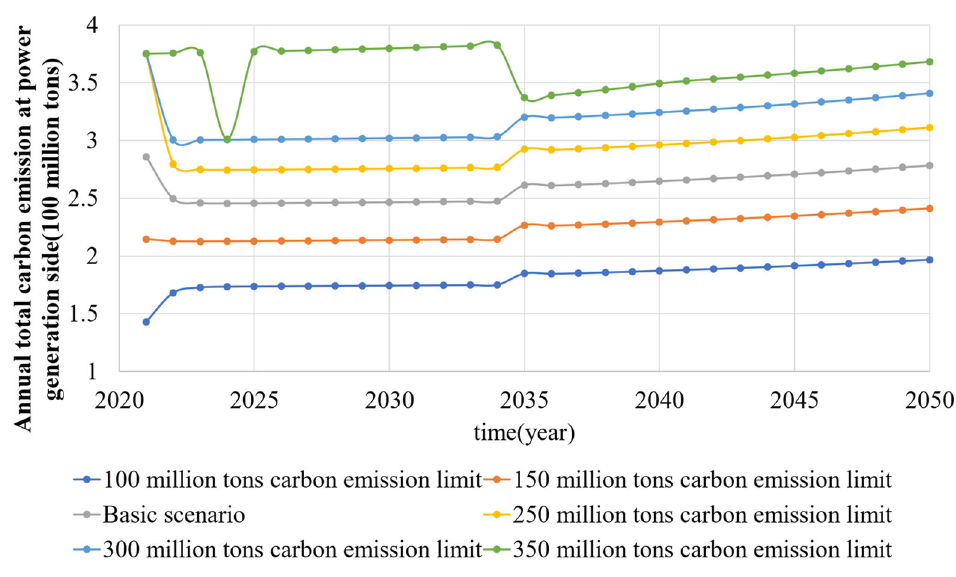
Figure 15. Annual total carbon emission change in generation side based on carbon emission limit.